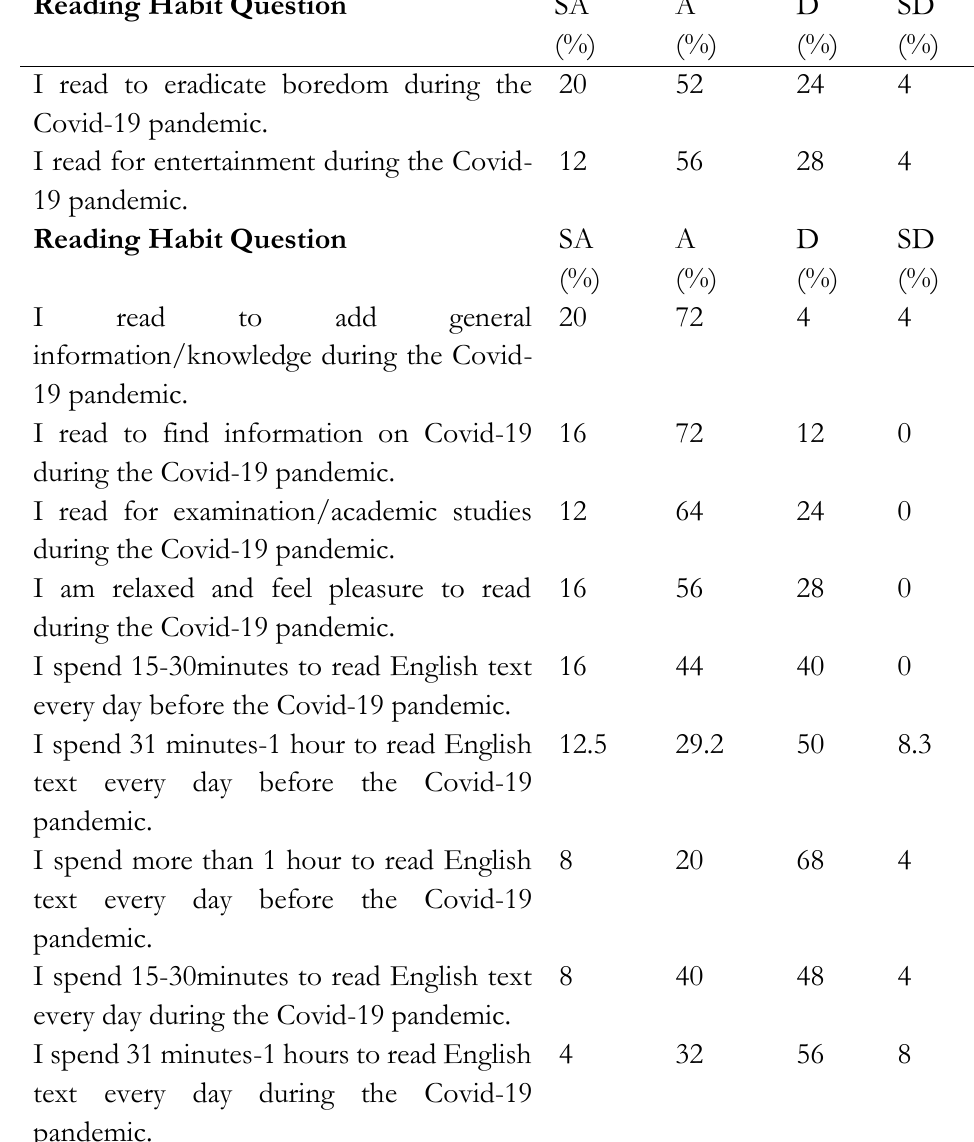
TABLE 1. Purpose for Reading and reading frequency during Pandemic